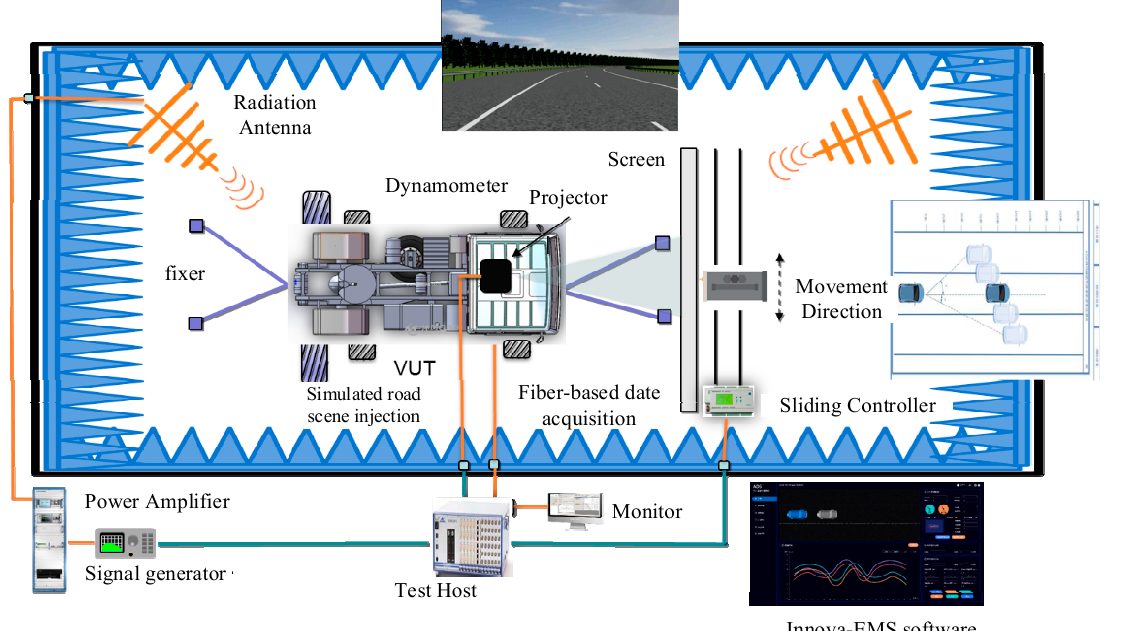
Figure 2. Developed test platform Innova-EMS to evaluate the radiation immunity of the vehicle from external radiation sources considering VHIL.